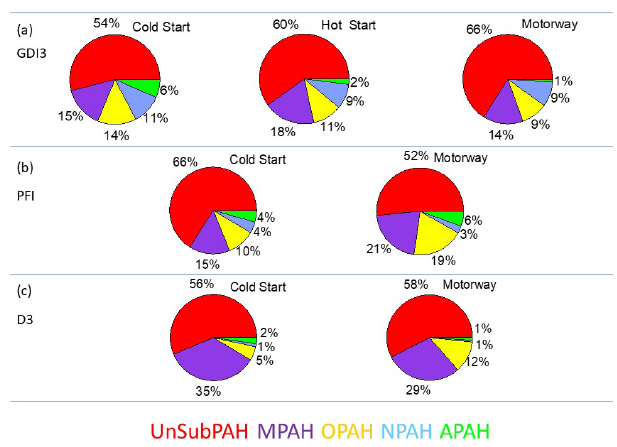
Figure 4. Average contribution of the various PAH families during Artemis cycles for GDI3 (a) , PFI (b) , and D3 (c) vehicles, using the method of Herring et al.